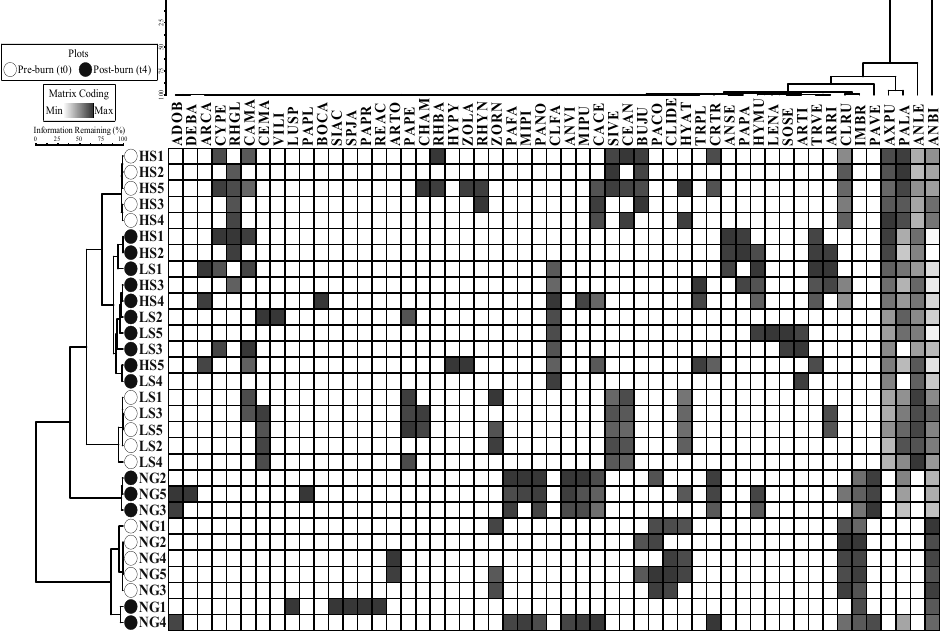
Figure 3. Two-way hierarchical cluster dendrogram showing the composition of vascular plant species (columns) in each plot for different grazing treatments (rows), for the pre- ( t 0) and the last post-burn ( t 4) surveys. Greyscale of squares represents the gradient in vegetation cover (%), where white squares indicate the absence of the species, and dark grey indicates the maximum cover range (75%–100%, e.g., for Andropogon bicornis in NG1). NG = non-grazed, LS = low stocking rate, HS = high stocking rate. Species codes appear in Table S1.